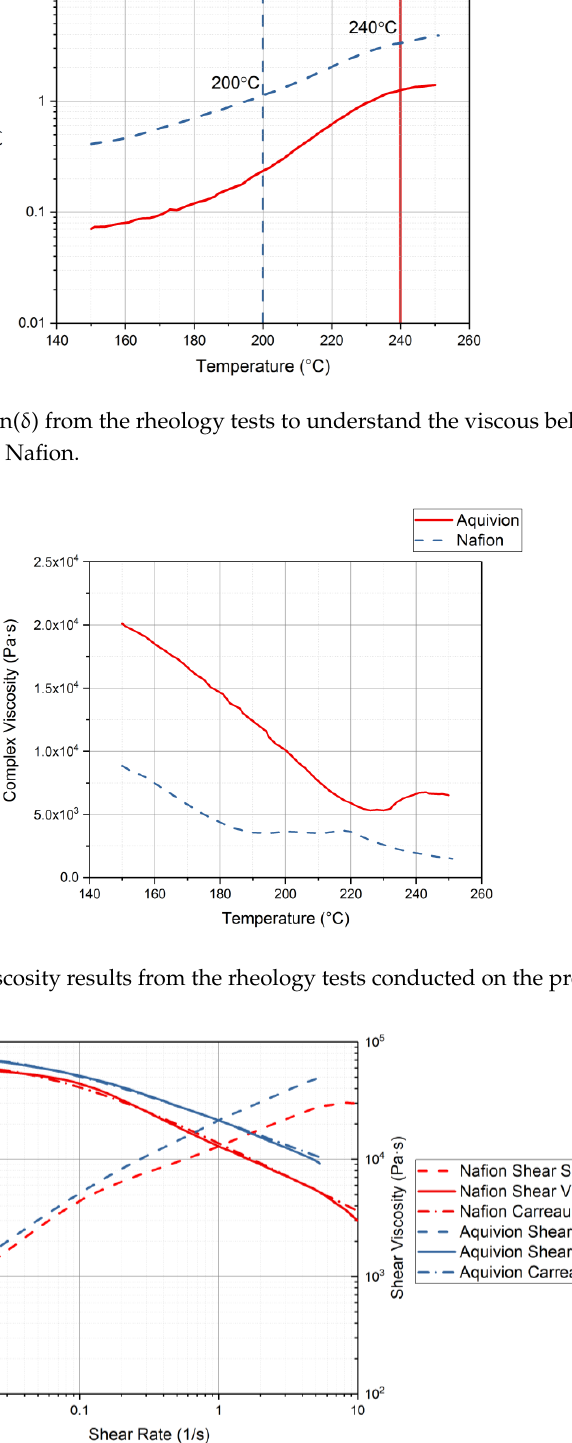
Figure 12. Rheology tests with applied shear rate to measure the shear stress and shear viscosity of the precursor-ionomers. Precursor Nafion was tested at 200 °C and precursor Aquivion was tested at 240 °C.